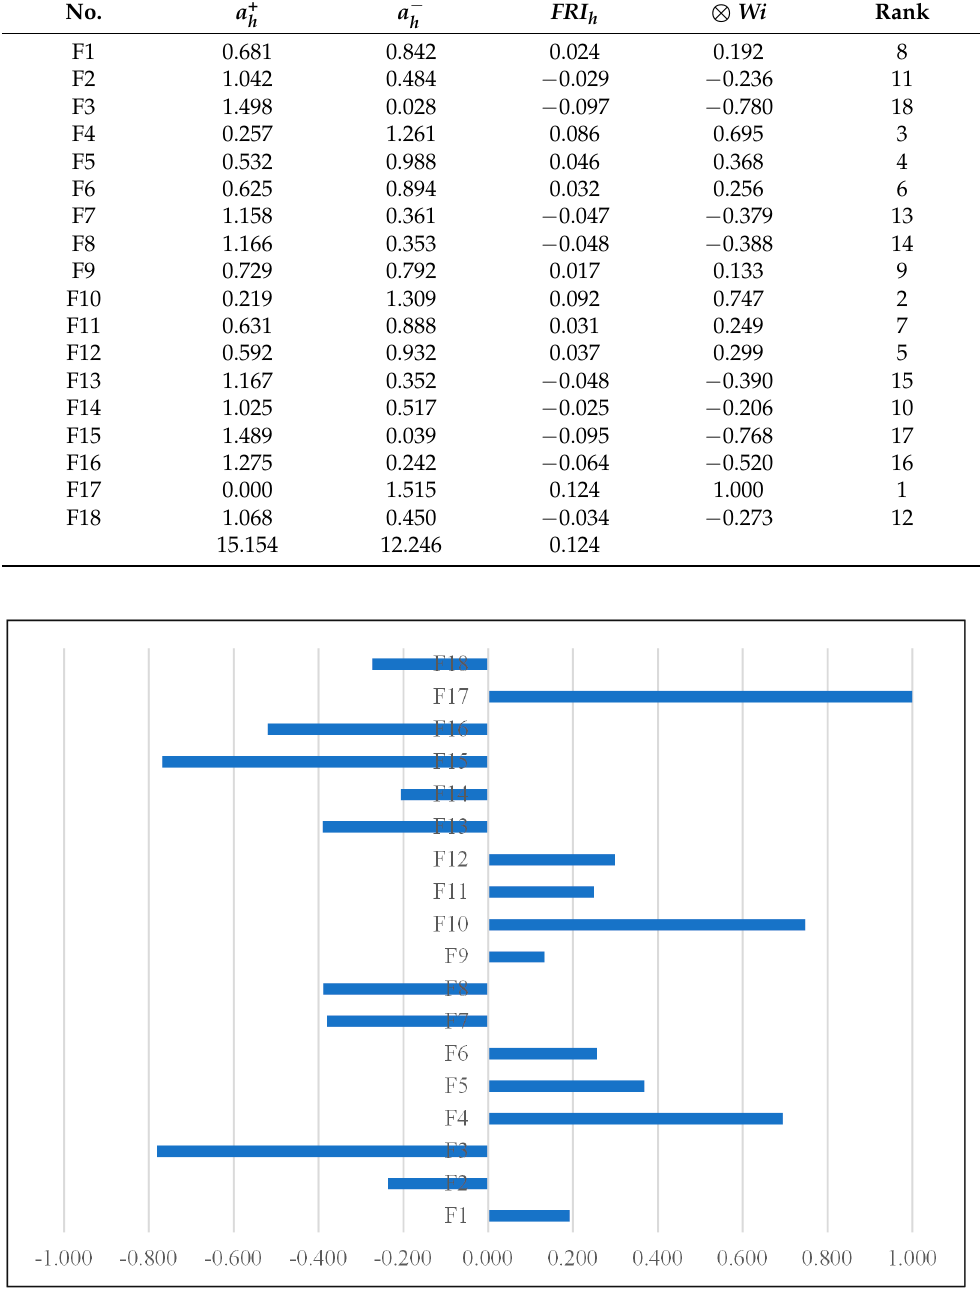
Figure 2. The PCIM − GRA method for ranking 18 failure modes.